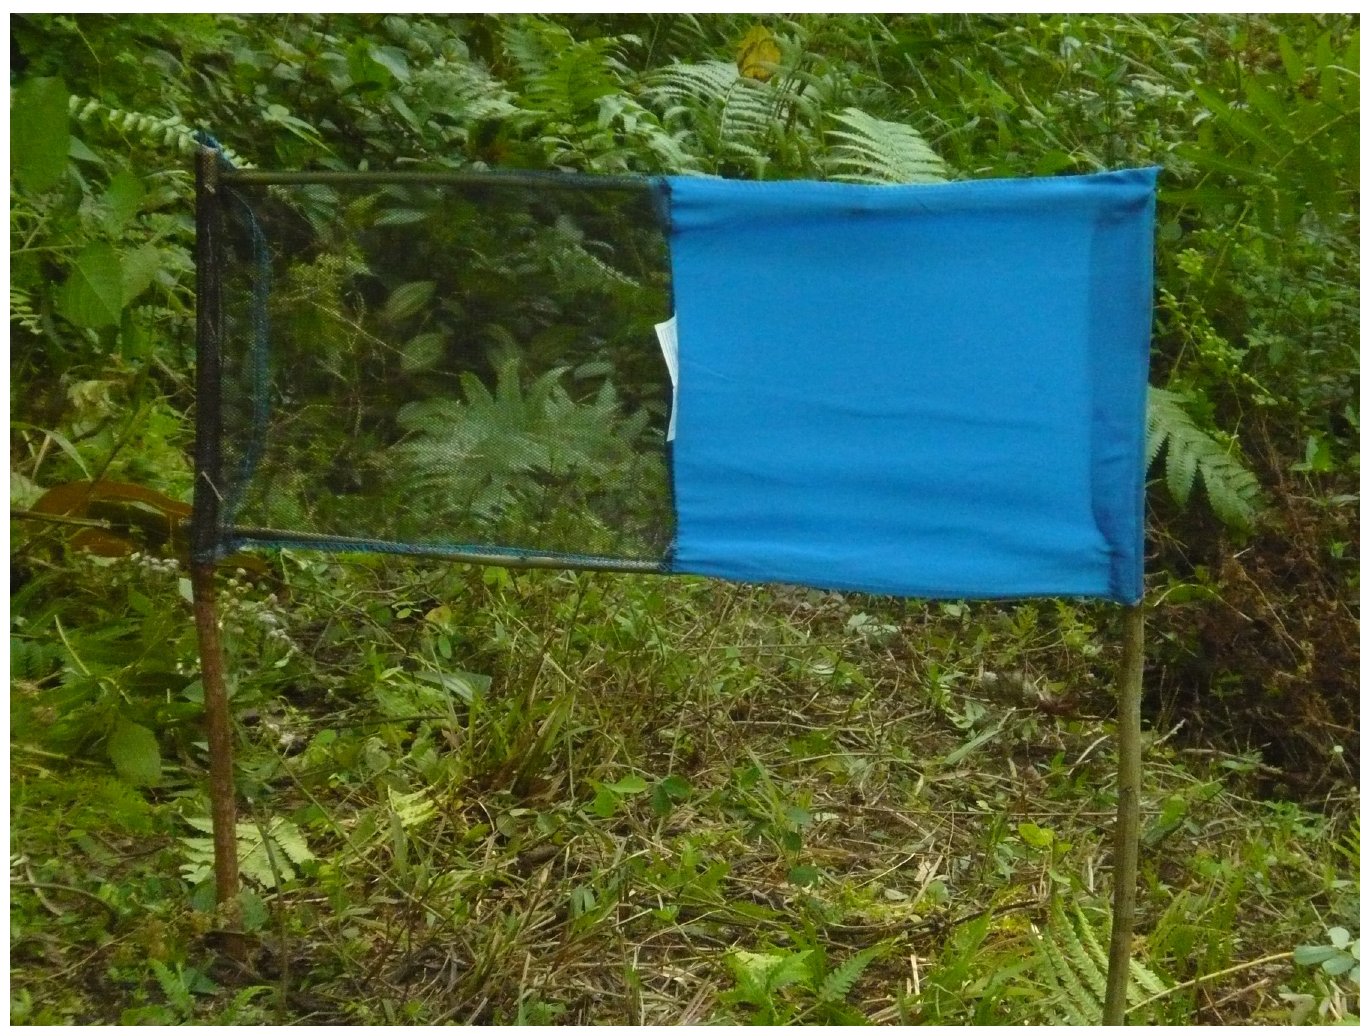
Fig 2. Tiny Target deployed by a Kisoko committee member. (Credit: